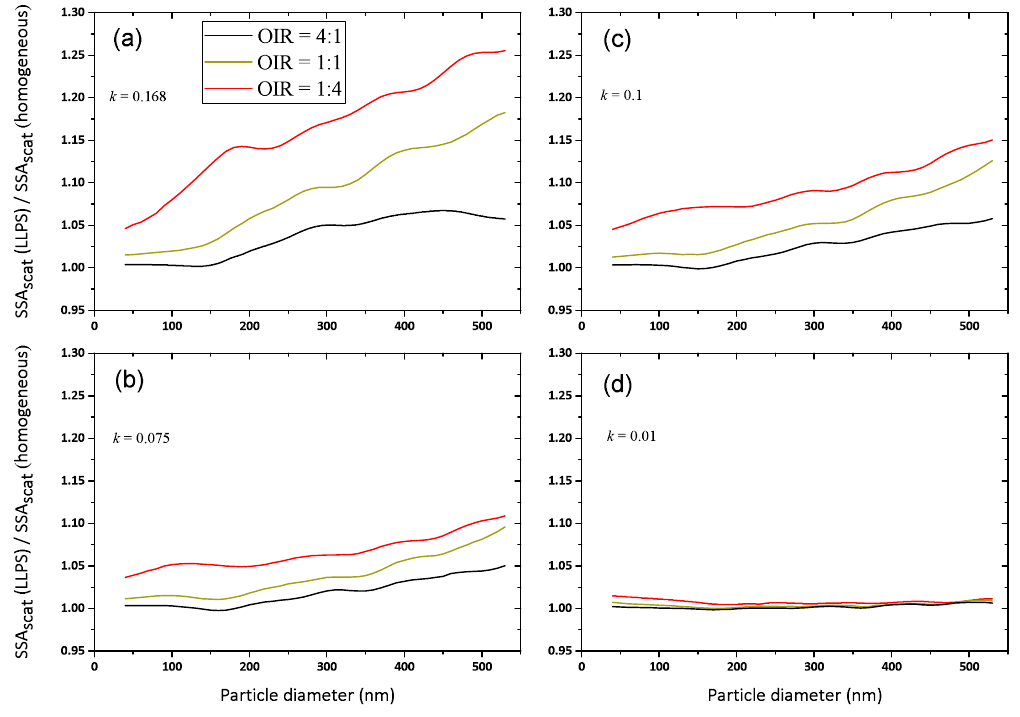
Figure 7. Ratios of SSA for LLPS morphology over homogenous morphology as a function of particle diameter for OIR = 1 : 4, 1 : 1 and 4 : 1, with decreasing absorption from (a) to (d) , k = 0 . 168, 0.1, 0.075 and 0.01 (same parameters as in Fig. 6; for details, see Tables A1 and A2). Here, we show only the data calculated for concentric core-shell